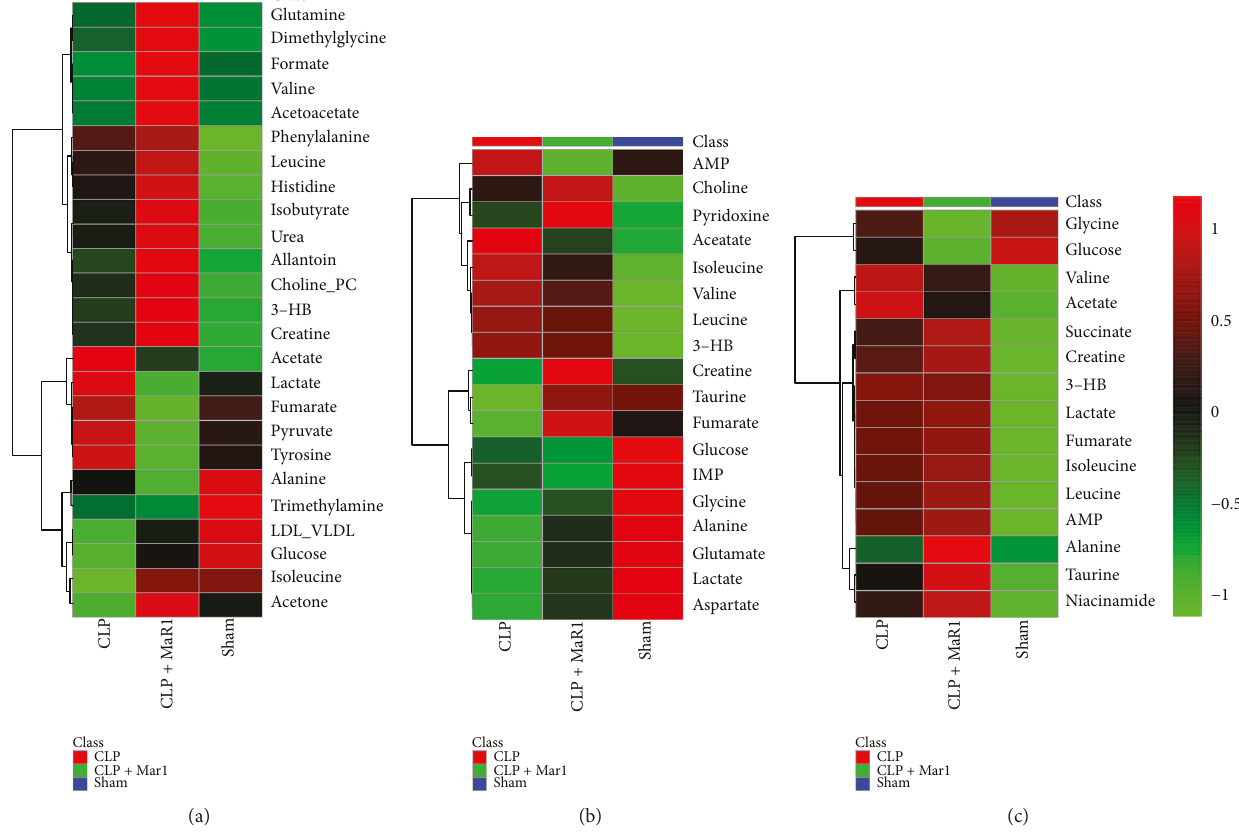
Figure 6: Heat map visualization of the identi fi ed di ff erential metabolites in septic mouse treatment with MaR1. Heat maps of metabolites in serum (a), lungs (b), and liver (c) of septic mouse treatment with